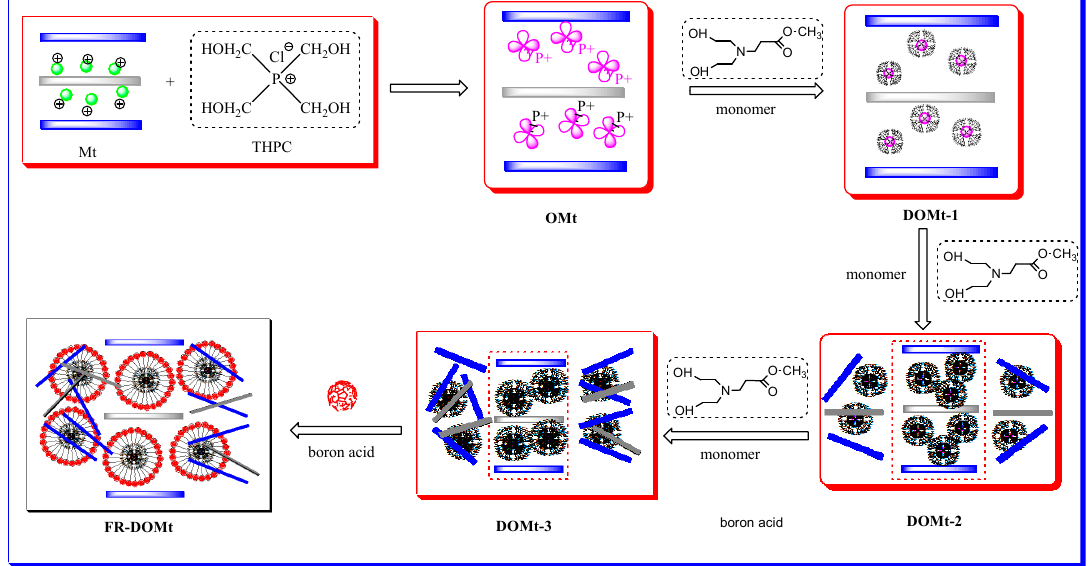
Scheme 1. Preparation process of FR-DOMt.